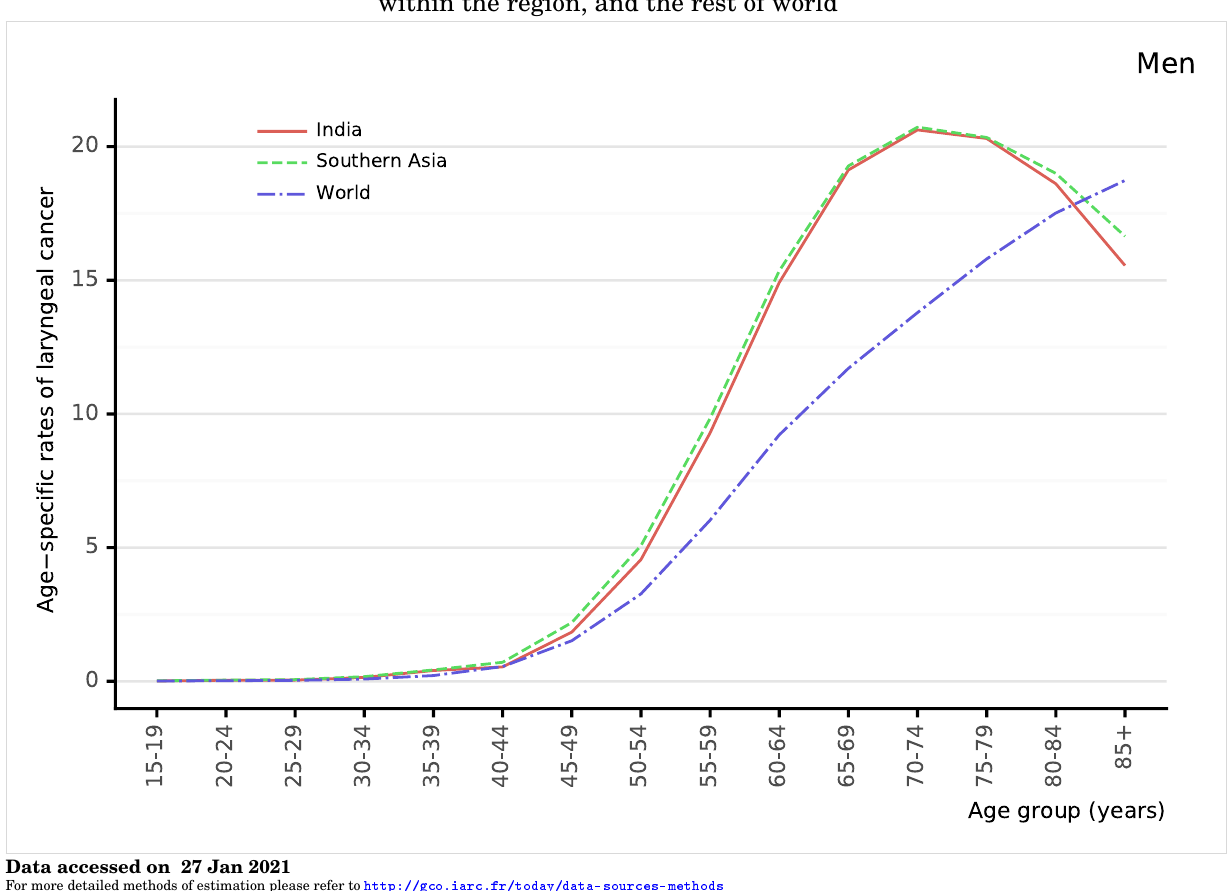
Figure 135: Comparison of age-specific laryngeal cancer mortality rates among men by age in India, within the region, and the rest of